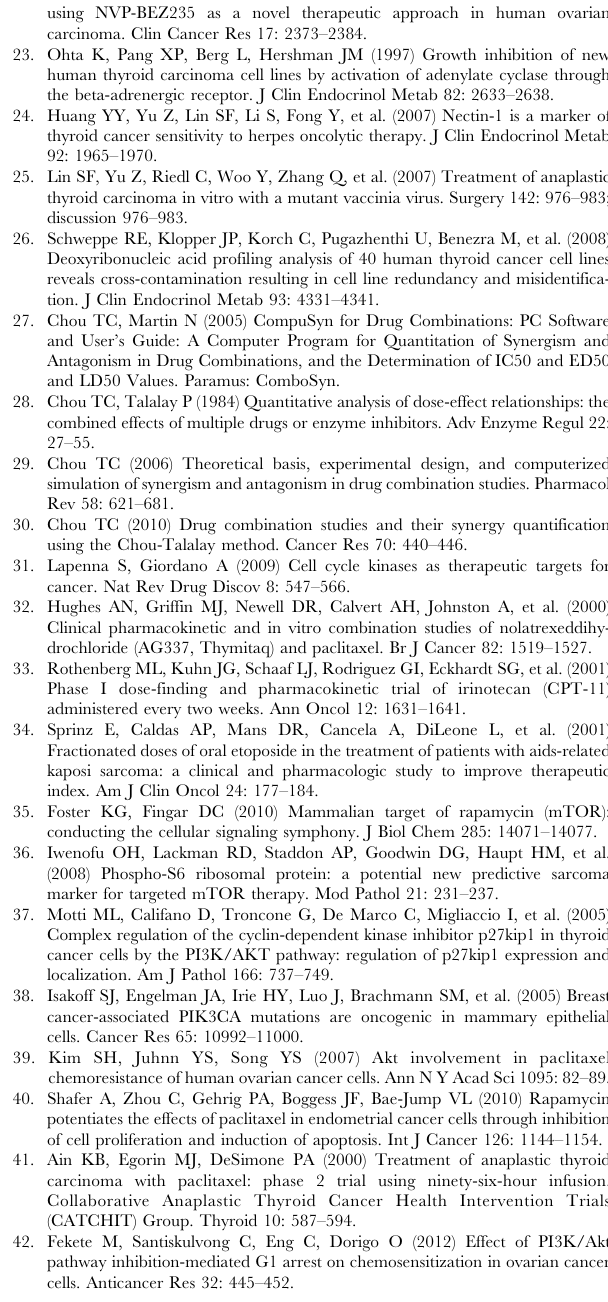
Figure S6 Five chemotherapeutic agents induce dose and time dependent cytotoxicity in 4 anaplastic thyroid cancer cell lines. Dose-response curves were obtained on day 3 and 4 from cells treated with serial dilutions of chemotherapeutic agents (paclitaxel, irinotecan, etoposide, 5-FU, doxorubicin) for a 4-day course on ATC cell lines using LDH assays. All drugs demonstrated dose and time dependent cytotoxicity in four cell